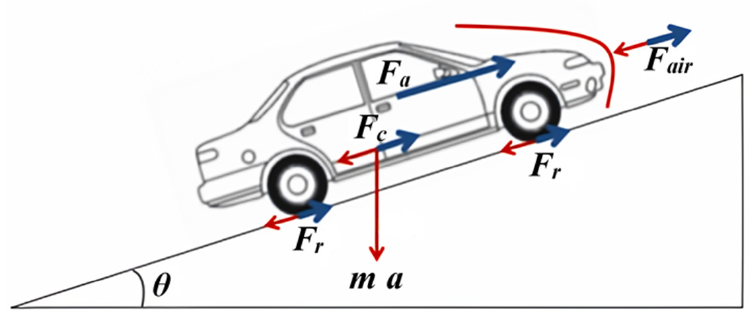
Figure 2. Force diagram on EV.